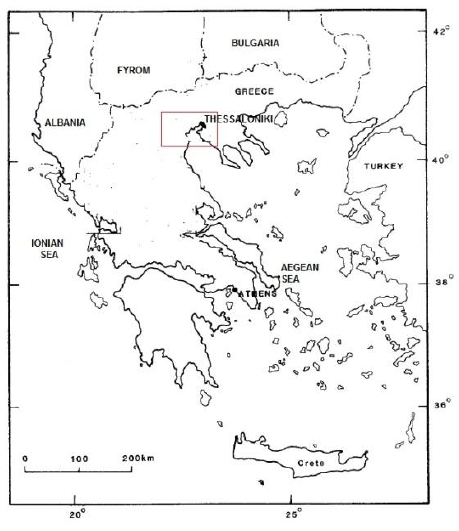
Figure 1. The wider study